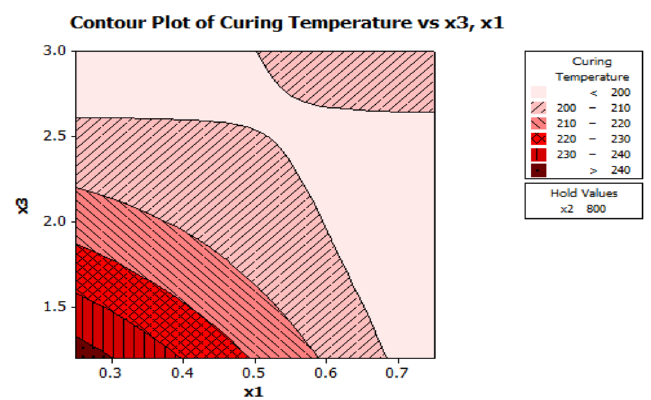
Figure 16. Contour plot for substitution of phenol with lignin (X 1 ) and F/P (X 3 ) on curing temperatures of BPF resoles at lignin M w of 800 g/mol.